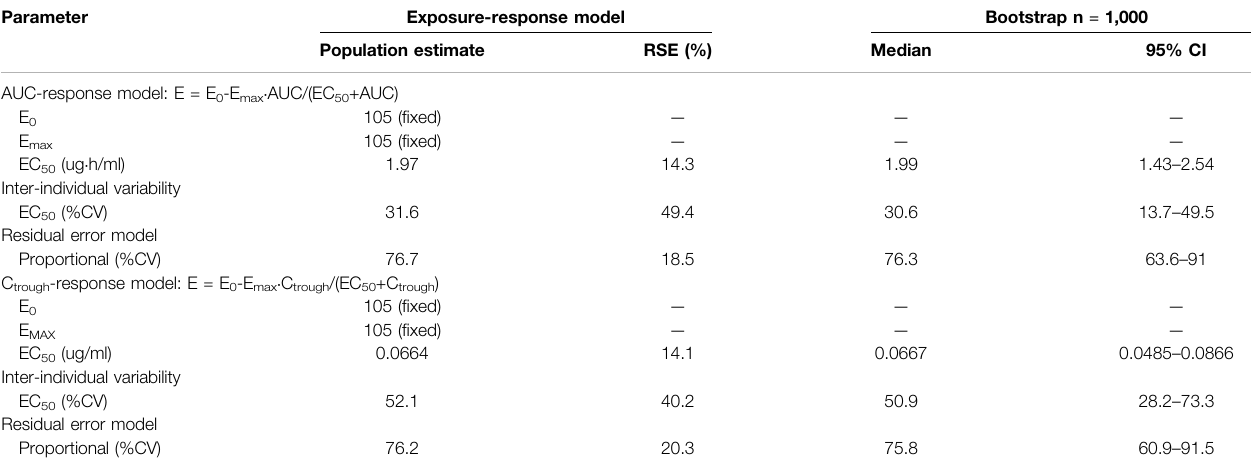
TABLE 4 | Parameter estimates of the mycophenolic acid exposure-response model and bootstrap validation. Parameter